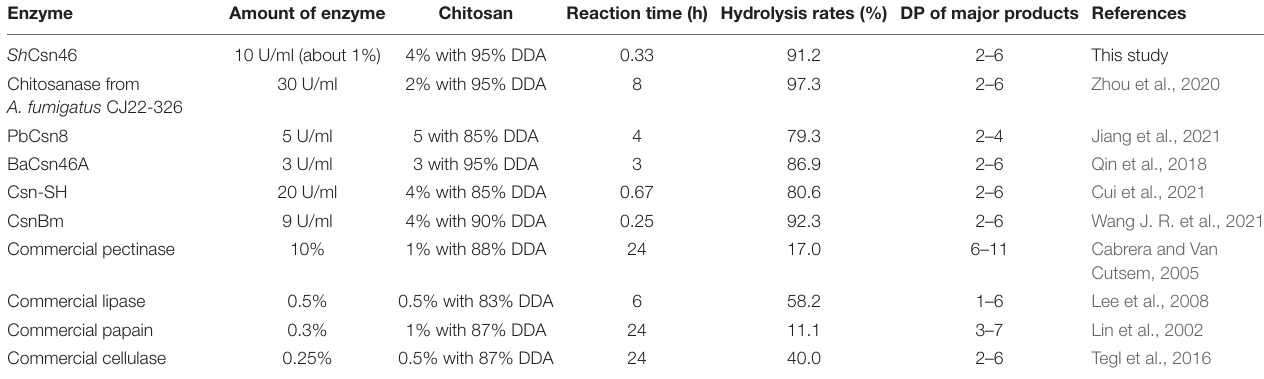
FIGURE 6 | Preparation of COSs by Sh Csn46. (A) TLC analysis of hydrolysates from 4% (w/v) colloidal chitosan addition with different amounts of Sh Csn46. (B) HPLC analysis of COSs output from different hydrolysates. The effects of different Sh Csn46 additions on the production of the same COS were analyzed. Different lowercase superscripts in the columns with the same color indicate statistical difference ( p < 0.05). (C) The hydrolysis rate of 4% colloidal chitosan addition with different amounts of Sh Csn46. (D) TLC analysis of hydrolysates from 4% colloidal chitosan addition with 10 U/ml purified Sh Csn46 at different reaction times. (E) HPLC analysis of COSs output from 4% colloidal chitosan addition with 10 U/ml purified Sh Csn46 at different reaction times. (F) The hydrolysis rates of 4% colloidal chitosan with 10 U/ml purified Sh Csn46 at different reaction times. (G) The precipitation of undegraded chitosan with 10 U/ml purified Sh Csn46 at different reaction times. TABLE 4 | Enzymatic conversion of chitosan to